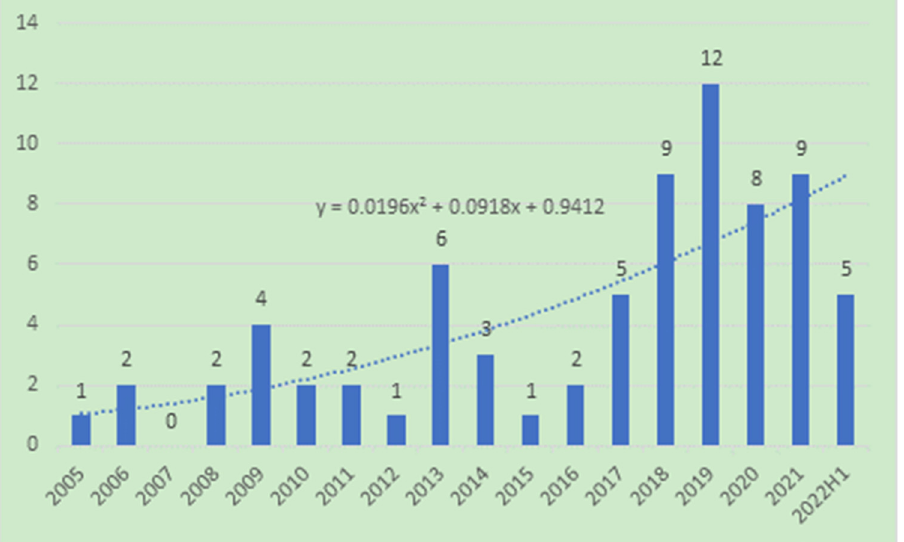
Figure 2. Year profile of publication. Note: The X-axis represents the different years and the Y-axis represents the number of publications published in each year.